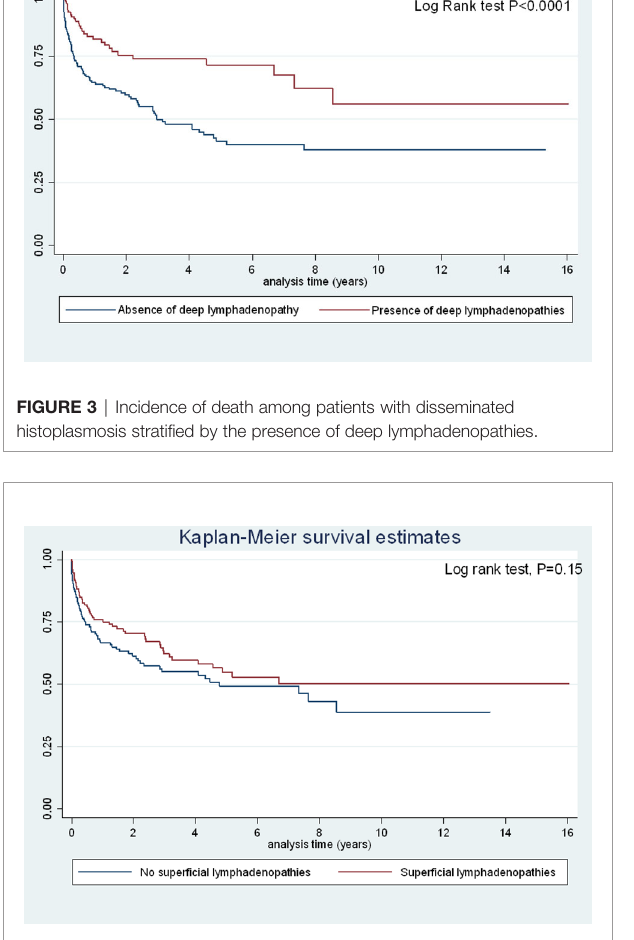
FIGURE 4 | Incidence of death among patients with disseminated histoplasmosis strati fi ed by the presence of super fi cial